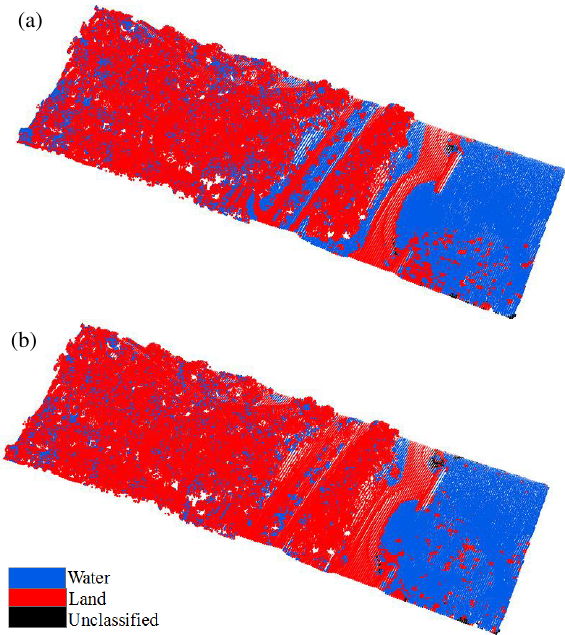
Figure 9. Labelled LiDAR points of Site I from number of returns with a) NDFI G-NIR / b) NDFI G-MIR